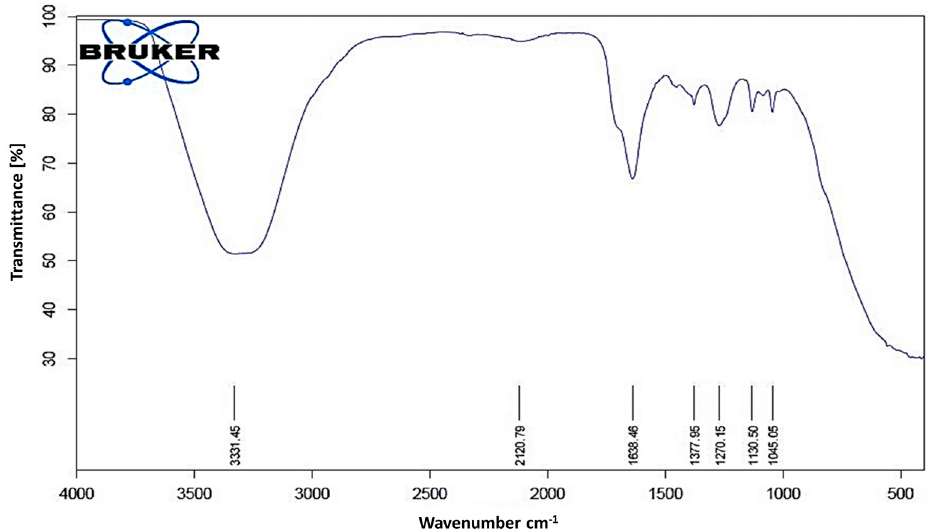
Figure 6. FTIR spectrum of L. coryniformis BCH-4 AMCs. The spectrum shows a range of 4000 to 500 cm − 1 wave number (along x-axis) and % transmittance (along y-axis). The numbers above x-axis are representing specific functional group wave numbers (cm − 1 ) which are present in L. coryniformis BCH-4